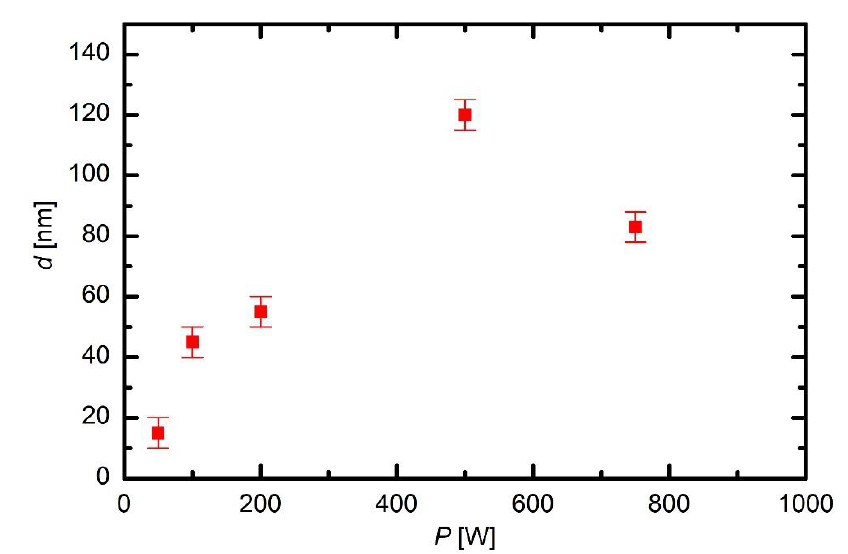
Figure 11. The thickness of coatings on samples versus the discharge power (30 s in HMDSO plasma at 10 Pa).